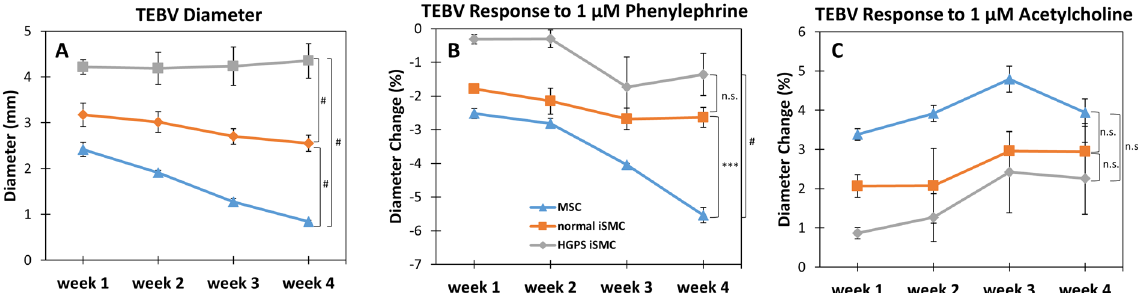
Figure 2. Functional characterization of MSC or iPSC-derived SMC TEBVs from healthy and Progeria patients. ( A ) Weekly outer diameter measurements of TEBVs fabricated with either MSCs, normal iSMCs, or HGPS iSMCs and seeded with hCB-ECs. ( B ) Weekly response to 1 μ M phenylephrine of TEBVs fabricated with either MSCs, normal iSMCs, or HGPS iSMCs and seeded with hCB-ECs. ( C ) Weekly response to 1 μ M acetylcholine of TEBVs fabricated with either MSCs, normal iSMCs, or HGPS iSMCs and seeded with hCB- ECs. Data are represented as mean ± S.E.M. n = 3 TEBVs. n.s. = not significant, *** P < 0.001, # P < 0.0001 at week